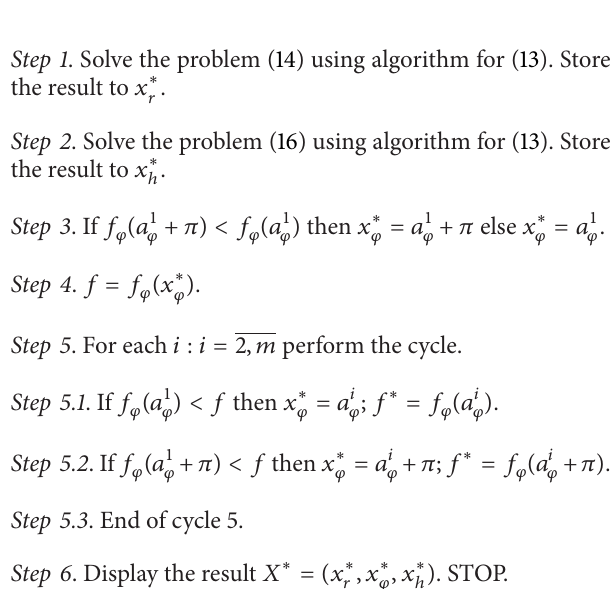
Algorithm 6. Solving the location problem with the “lifting crane”